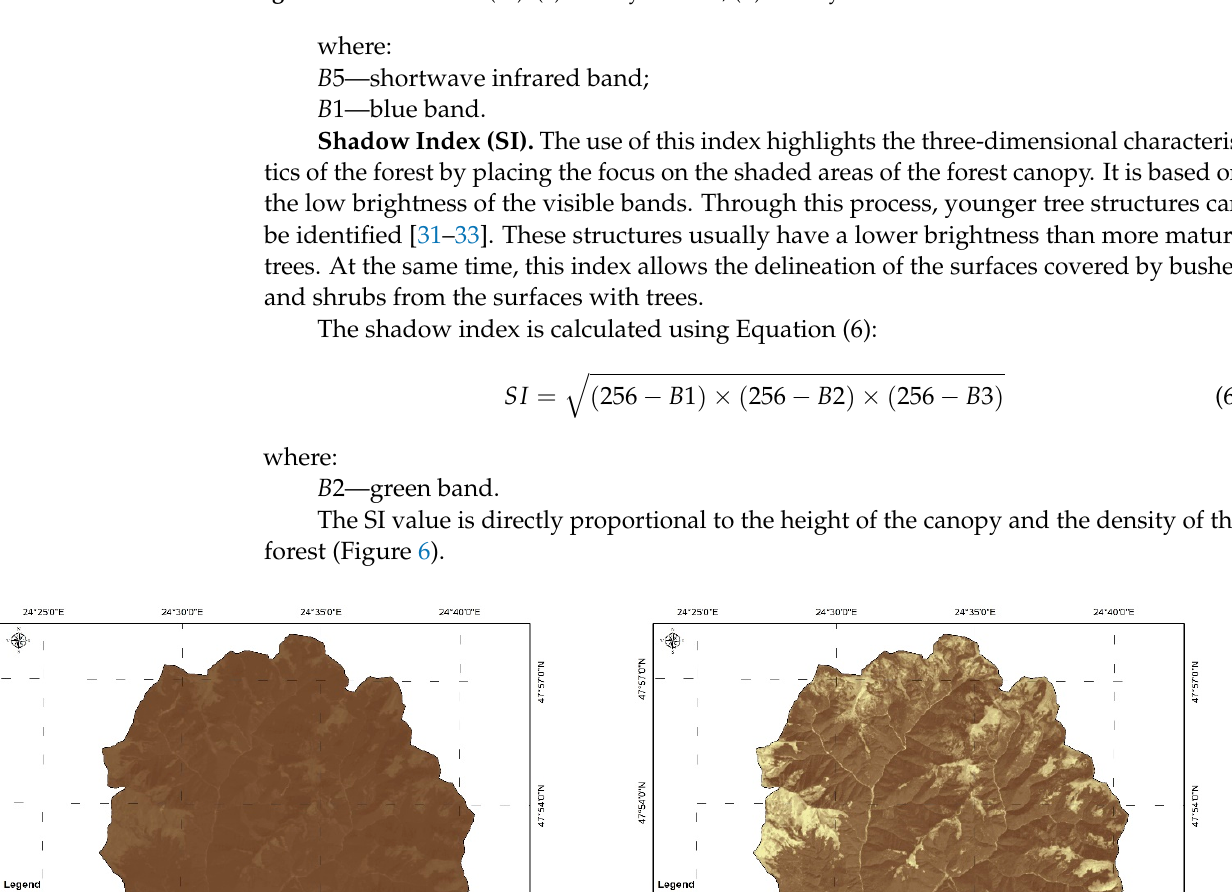
be identified [31–33]. These structures usually have a lower brightness than more mature trees. At the same time, this index allows the delineation of the surfaces covered by bushes and shrubs from the surfaces with trees.